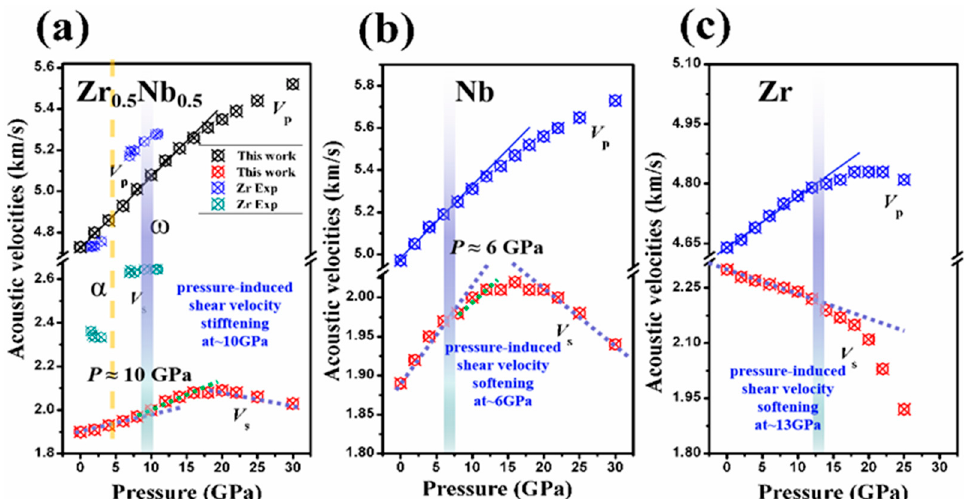
Figure 3. Theoretical prediction of acoustic velocities at high pressure for cubic Zr 0.5 Nb 0.5 ( a ), Nb ( b ), and hcp -Zr ( c ) metals, where a pronounced pressure-induced anomaly in V S is observed at pressures of ~10 GPa, ~6 GPa, and 13 GPa, respectively, owing to the pressure-driven structural instability of materials upon compression.